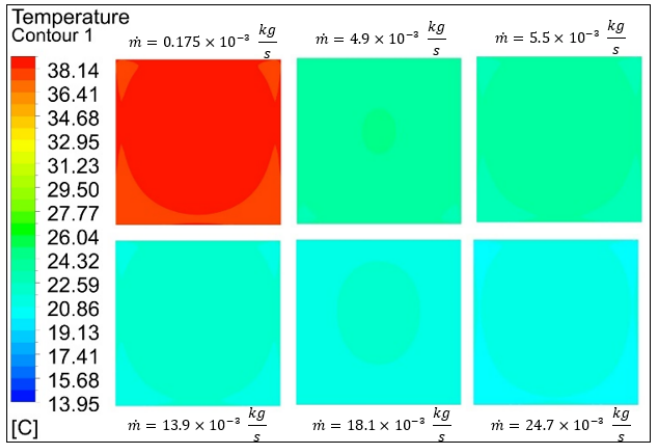
Figure 16. Temperature distribution on MJPV surface at different mass flow rates.